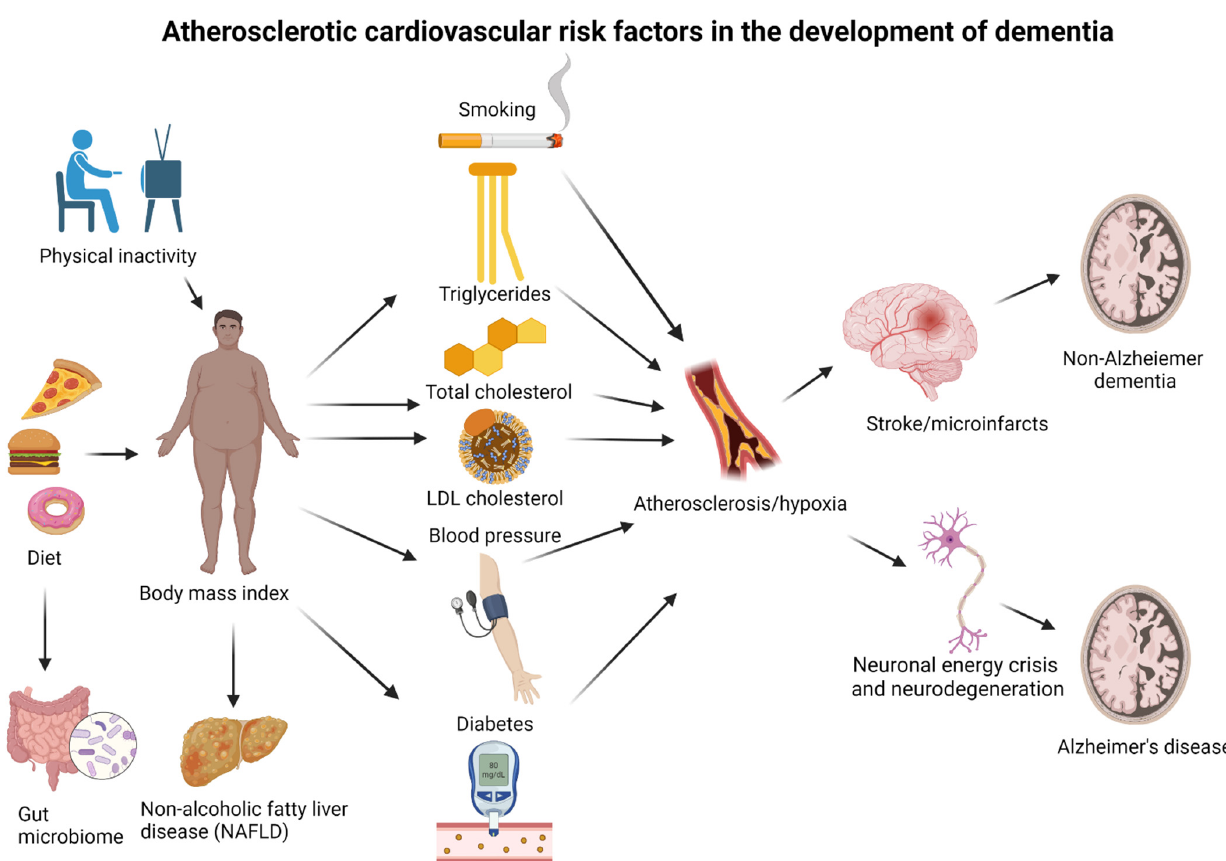
Figure 9. Proposed pathways from atherosclerotic cardiovascular risk factors for dementia to the development of disease. (1) The body mass index is influenced by the level of physical activity and diet, and the gut microbiome is influenced by diet composition. (2) The body mass index influences LDL cholesterol and triglyceride concentrations, blood pressure, and risk of diabetes and NAFLD. (3) Smoking, LDL cholesterol, triglycerides, blood pressure, and diabetes are all risk factors for developing atherosclerosis. (4) Atherosclerosis can cause long-term reduced cerebral blood flow and hypoxia if vessels are not completely blocked, leading to neuronal energy crisis, neurodegeneration, and eventually, Alzheimer’s disease. Atherosclerosis can also cause acute hypoxia due to strokes, leading to vascular dementia. The association between high levels of HDL cholesterol and a high risk of dementia might be due to reverse causation caused by a low body mass index or due to high alcohol consumption. All risk factors can be influenced by genetics. Created with Biorender.com.